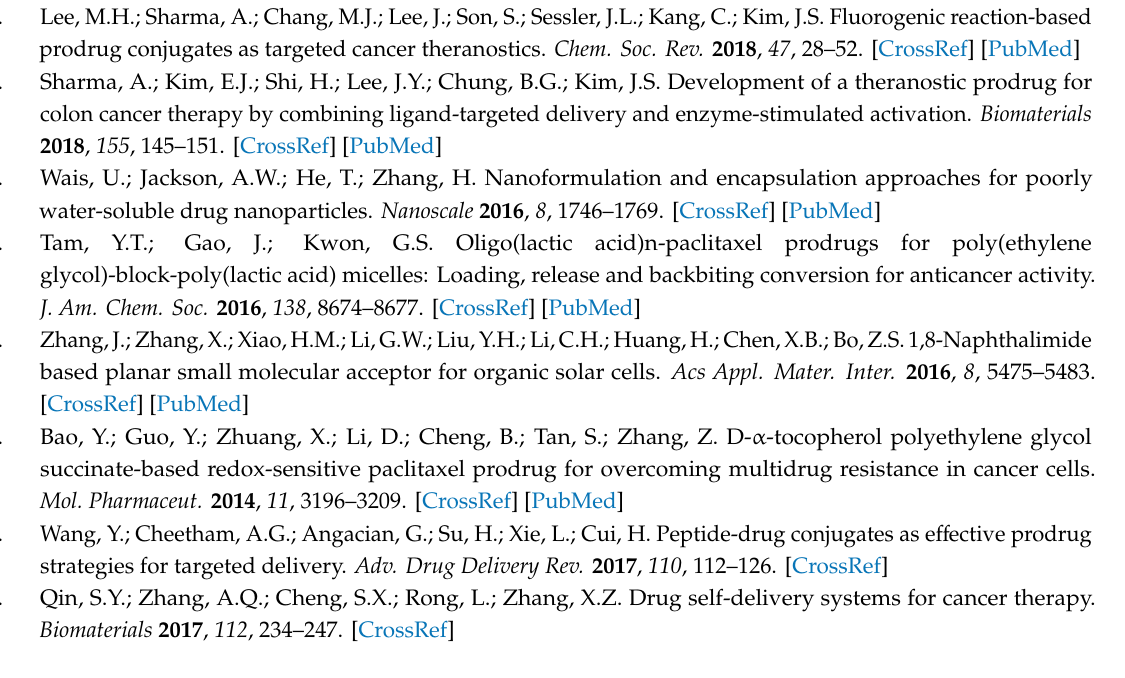
Figure S1. 1 H NMR of compounds after photolysis of MTX-ACM-PEG conjugate, (A) the compound of R t at 2.57 min and (B) R t at 7.85 min from HPLC; Figure S2. The size change of nanoparticles in di ff erent pH conditions (A), DLS curve of the nanoparticles in bu ff er solution after 10 h (B); Figure S3. The release profiles of nanoparticles in PBS (pH 7.4) with di ff erent concentration exposed to laser (365 nm, 5.0 W) for 1 h, (A) MTX-ACM-PEG conjugate in the solution; (B) the photocleavable release profiles of MTX from the nanoparticles. Means + SD (n = 3); Figure S4. The IC50 of the MTX and MTX-ACM-PEG nanoparticles against 4T1 cells, the incubation time was 48 h, the results were expressed as mean ± SD (n = 3); Figure S5. Compound 1 1 H NMR and 13 C NMR spectra; Figure S6. Compound 4 1 H NMR spectra; Figure S9. IR spectra; Figure S10. Mass